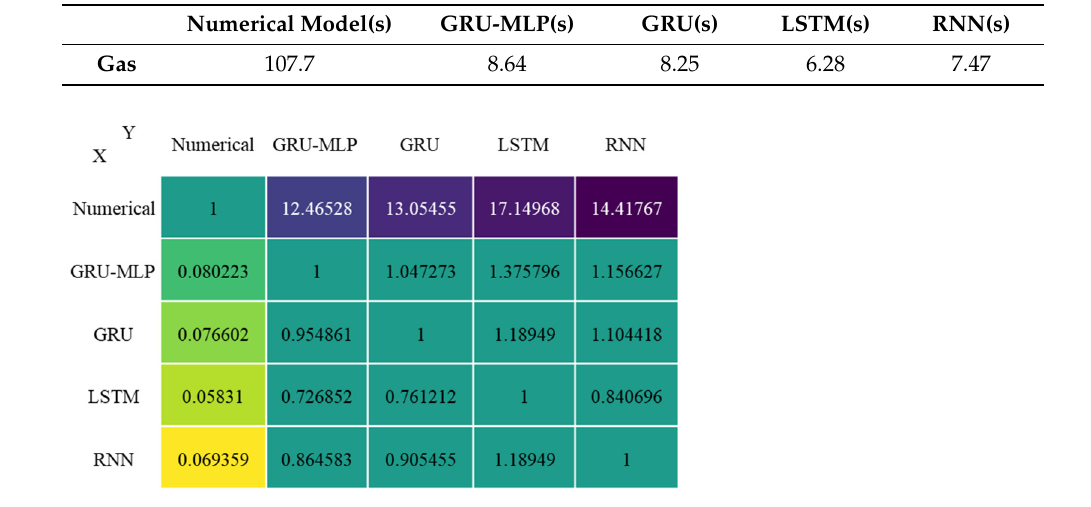
Figure 13. CPU time comparison between different models.